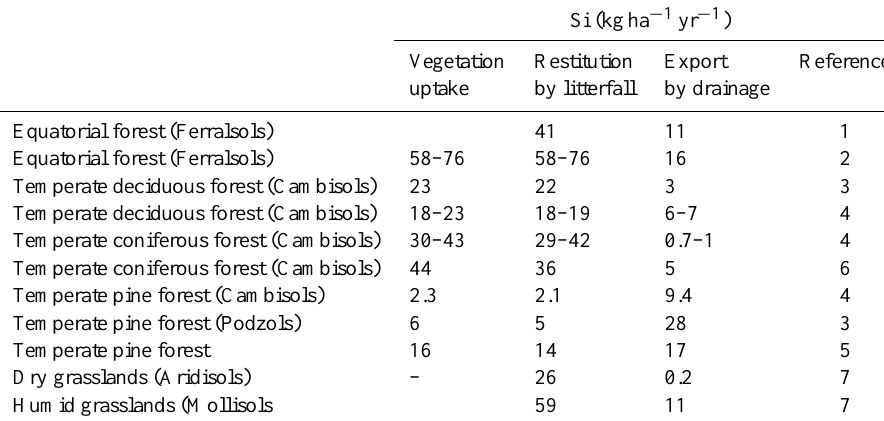
Table 3. Si fluxes (uptake, restitution and drainage) in forest and grassland